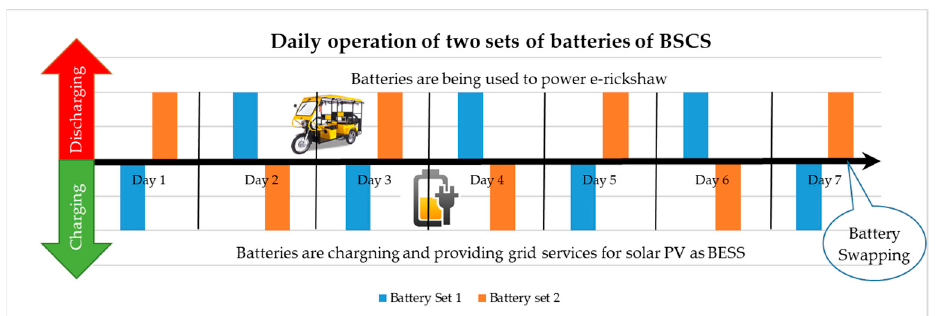
Figure 7. Daily operation of two sets of batteries.